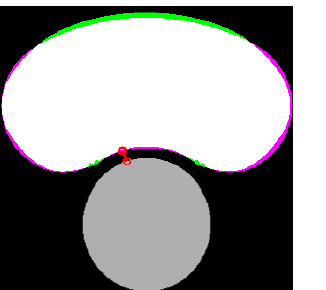
Figure 4. Comparison between the real and the segmented lipid core. The lumen is represented in gray color, the true positive area in white, the false negative area in green, the actual area that was not segmented in purple, and the measure of the FCT is the red